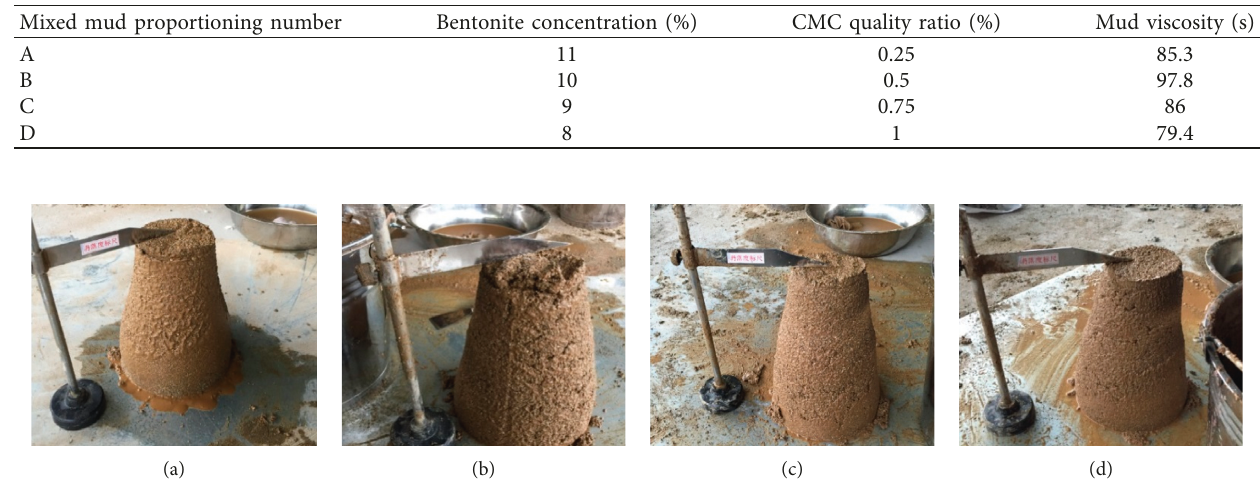
Figure 6: Slump of different matching when the solid-liquid volume ratio was 10:3. (a) Matching A. (b) Matching B. (c) Matching C. (d) Matching D.